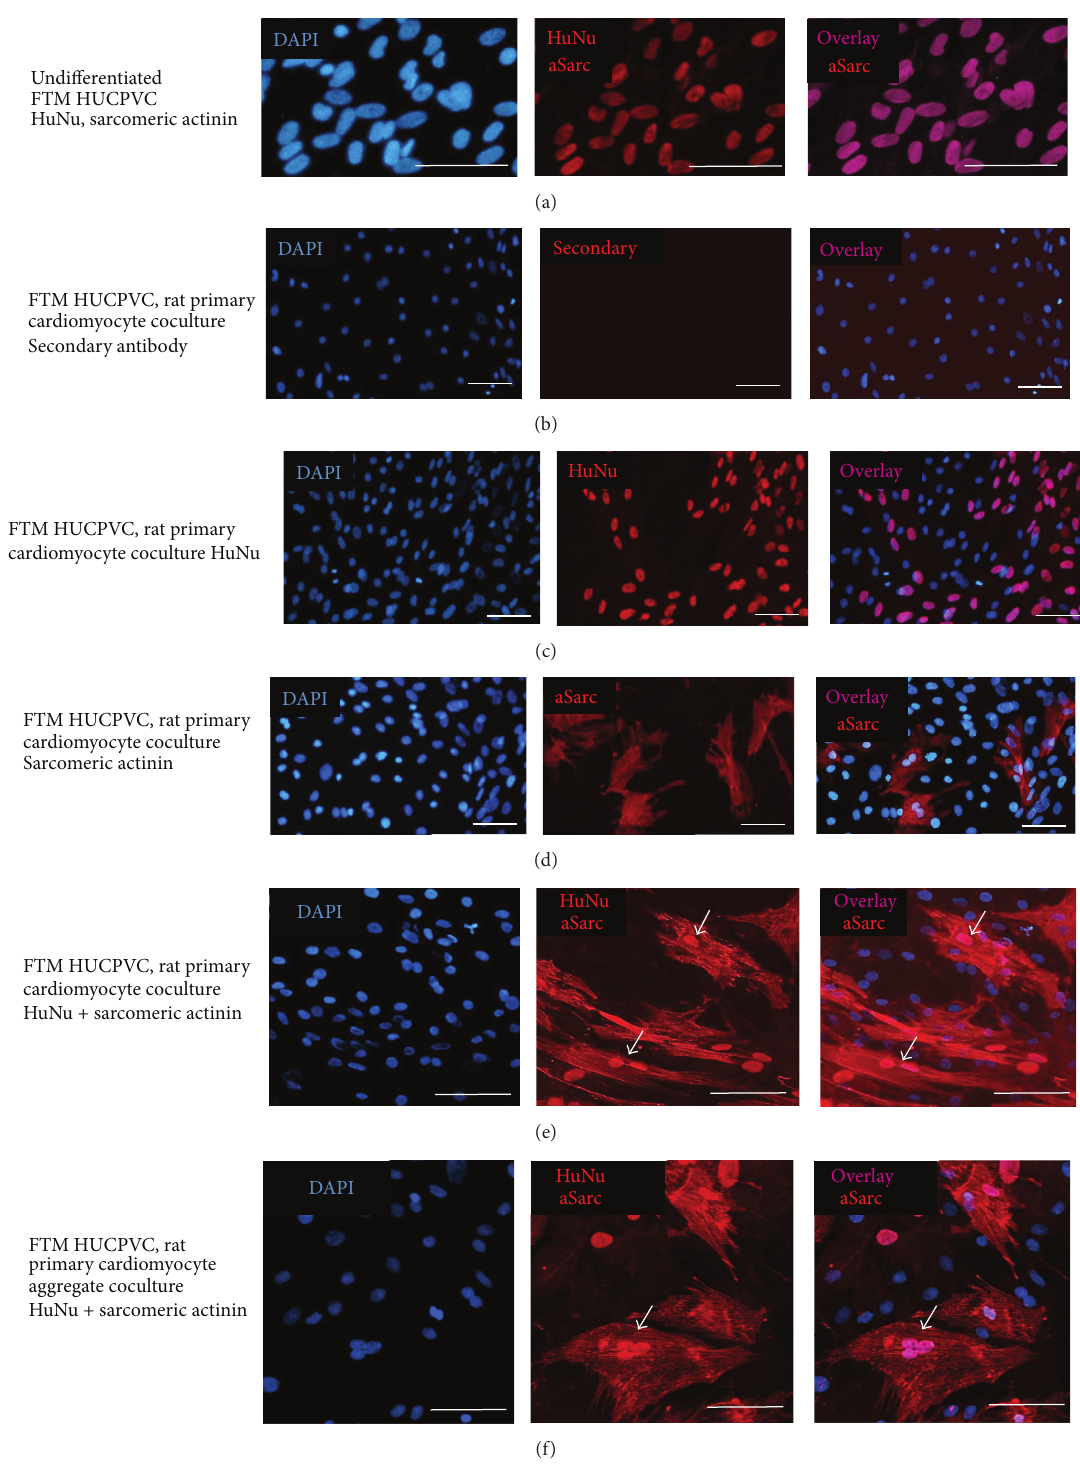
Figure 4: Alpha-sarcomeric actinin in FTM HUCPVCs after coculture differentiation. (a) Undifferentiated FTM HUCPVCs costained with human nuclear antigen- (HuNu-) specific and alpha-sarcomeric actinin- (aSarc-) specific antibodies. (b–d) Rat primary cardiomyocyte, FTM HUCPVC cocultures stained with secondary antibody only (b), human nuclear antigen- (HuNu-) specific (c) or alpha-sarcomeric actinin- (aSarc-) specific (d) antibody. (e, f) Rat primary cardiomyocyte, FTM HUCPVC cocultures costained with human nuclear antigen- (HuNu-) specific and alpha-sarcomeric actinin- (aSarc-) specific antibodies. DAPI: nuclear stain. Bar = 100 𝜇